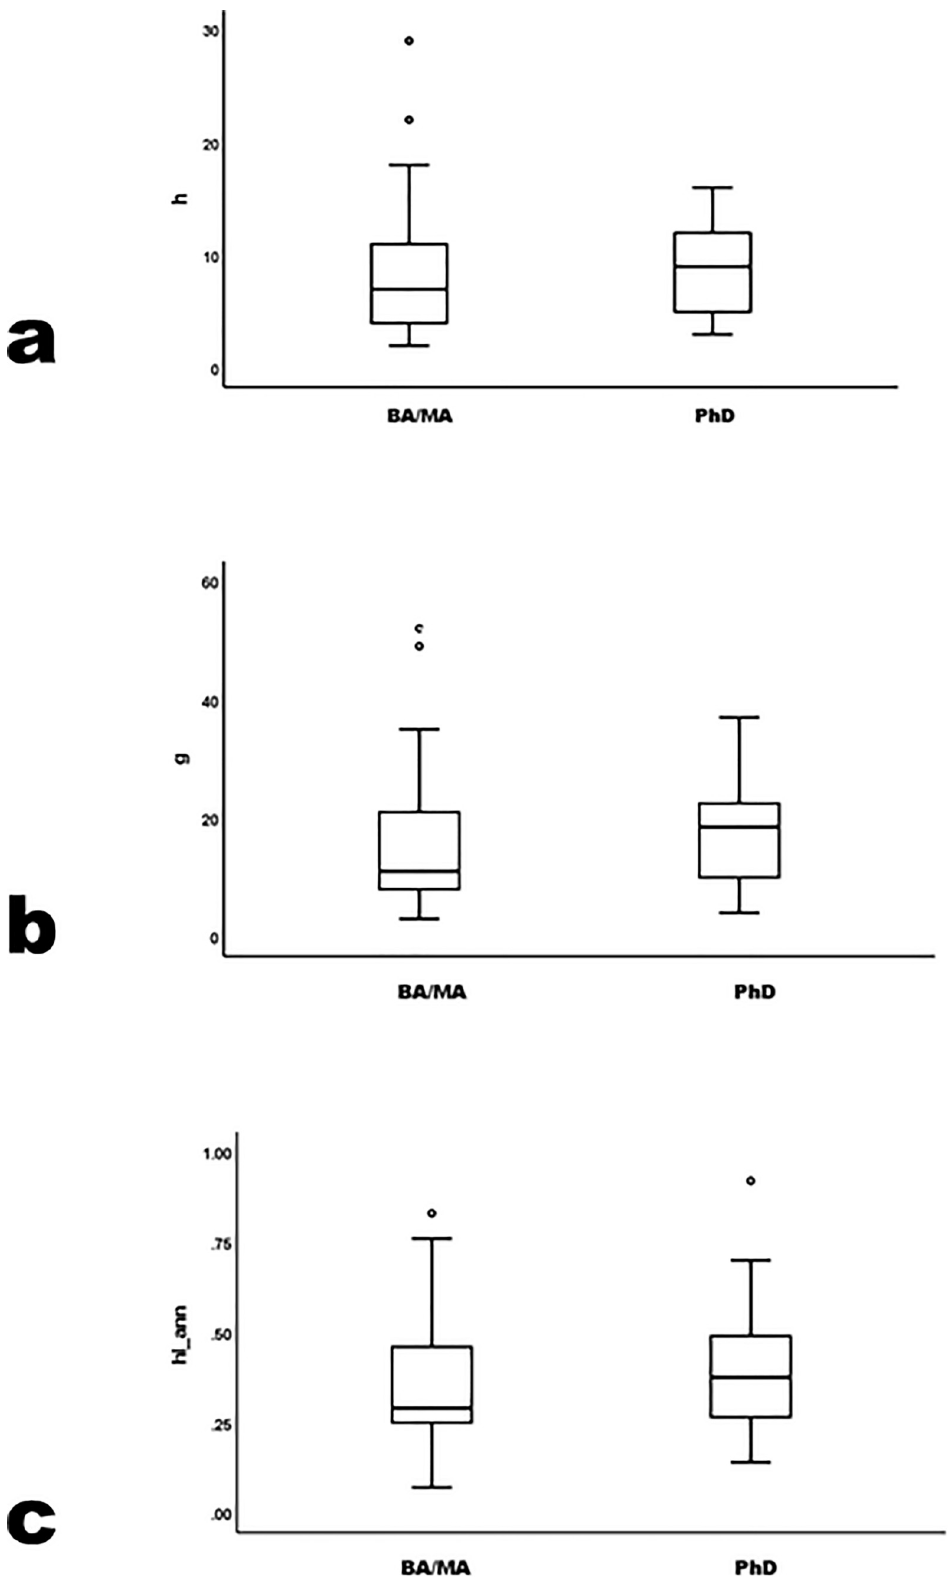
Fig 5. Trimmed-sample h , g and hIann by combined BA+MA versus PhD program.